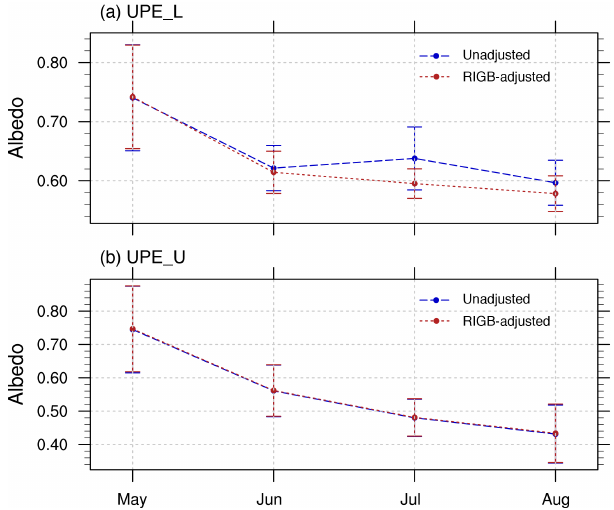
Figure 6. Monthly average albedo at (a) UPE_L and (b) UPE_U in May–August 2010 with standard deviation as error